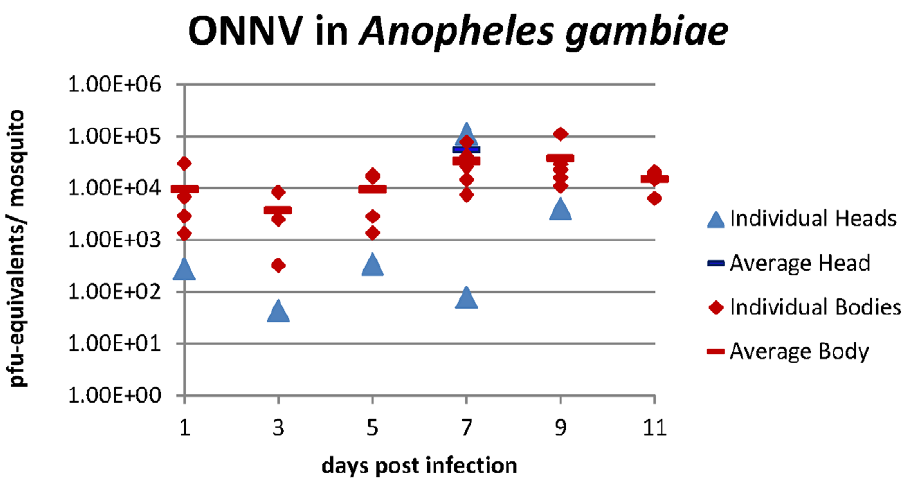
Figure 4. ONNV RNA quantification in An.gambiae by reverse-transcriptase real-time PCR. Five mosquitoes were analyzed for each timepoint and samples with positive values were plotted. Average values (represented by horizontal bars) were only calculated when more than one positive sample was present for that time point.